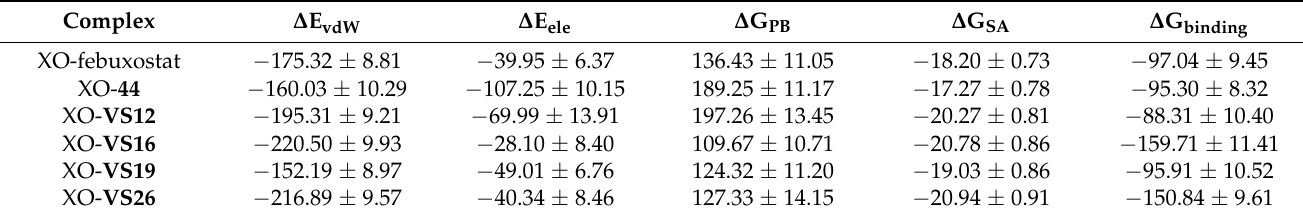
Table 7. The free binding energies (kJ/mol) of febuxostat, compound 44 , and the virtual-screened hits ( VS12 , VS16 , VS19 , and VS26 ) in the XO